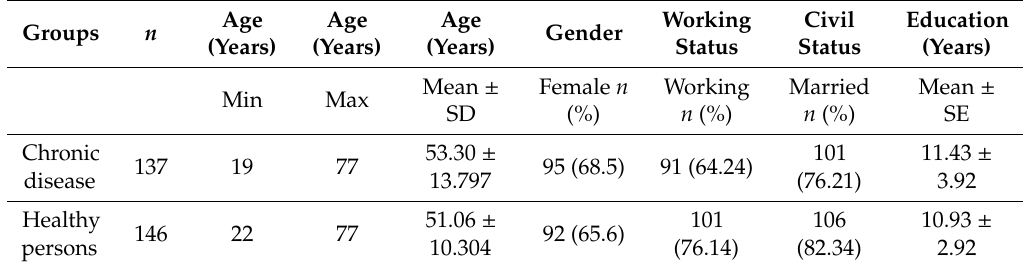
Table 1. Demographic characteristics of the clinical group.